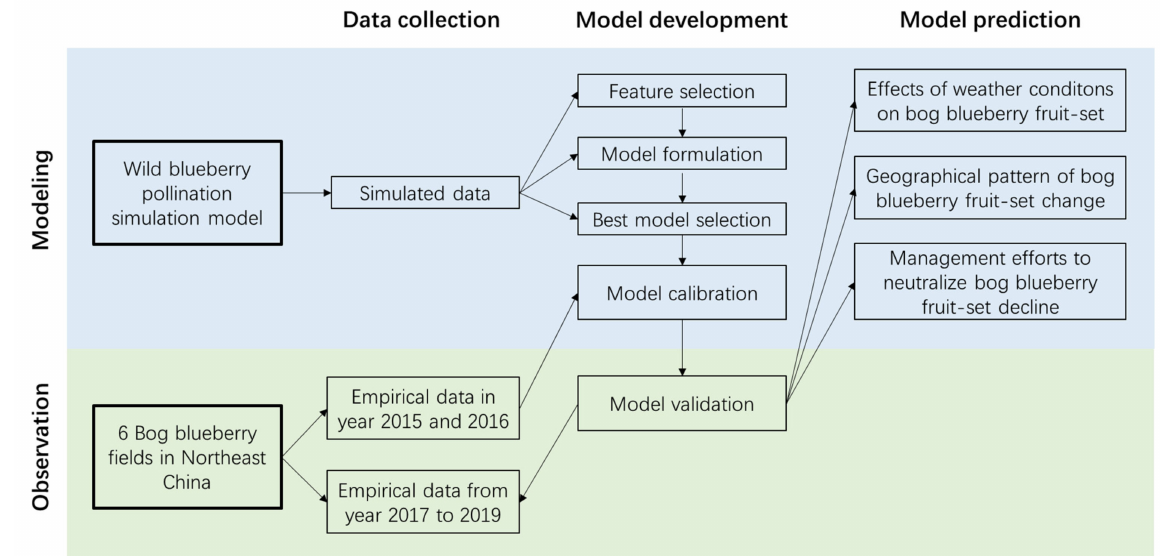
Figure 1. Flow diagram of the study’s stages and tasks.